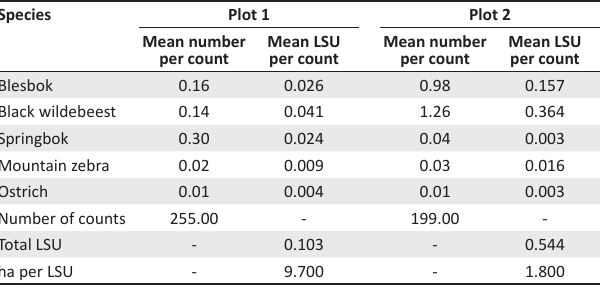
TABLE 2: Mean numbers of large herbivore species counted in two 1 ha sized plots from 1987 to 1989, with large stock unit equivalents and stocking rate expressed as ha per large stock unit equivalent.